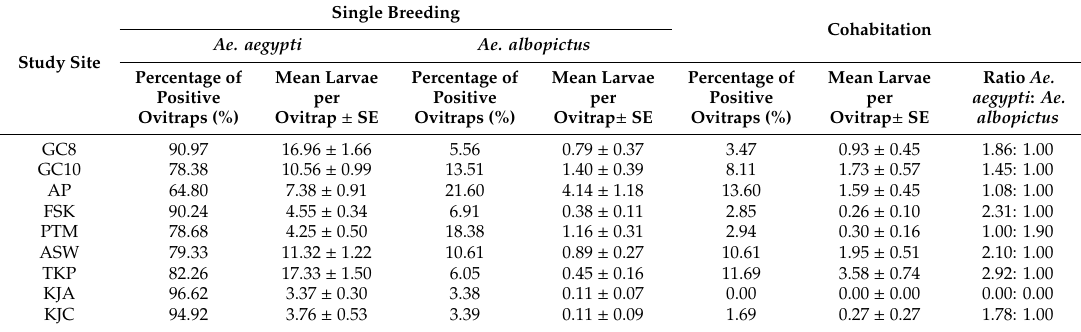
Table 3. Comparisons between single breeding and cohabitation of Aedes spp. in each study site.